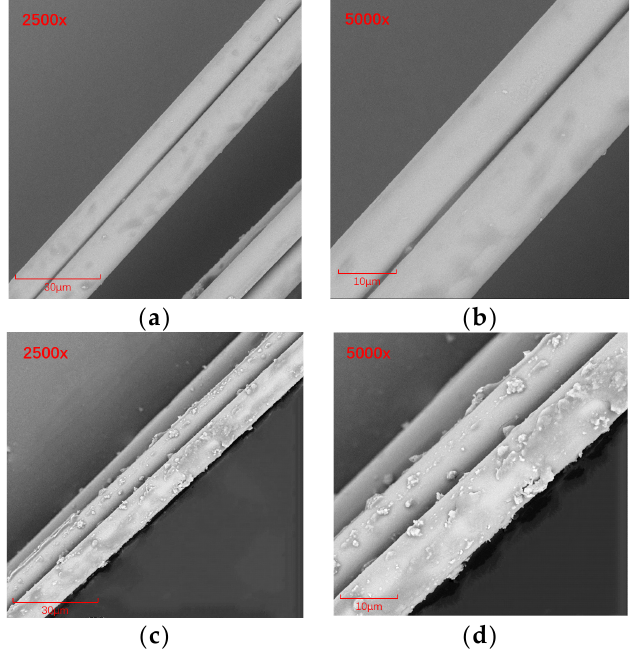
Figure 6. SEM images of basalt fiber before and after modification: ( a ) BF pretreated by 2500×; ( b ) 5000× pretreatment BF; ( c ) 2500× modified BF; ( d ) 50000× modified BF. (2) X-ray energy spectrometer (EDS)